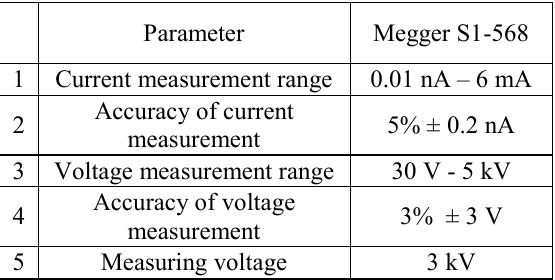
Table 2. Parameters of the used measuring instruments [5].